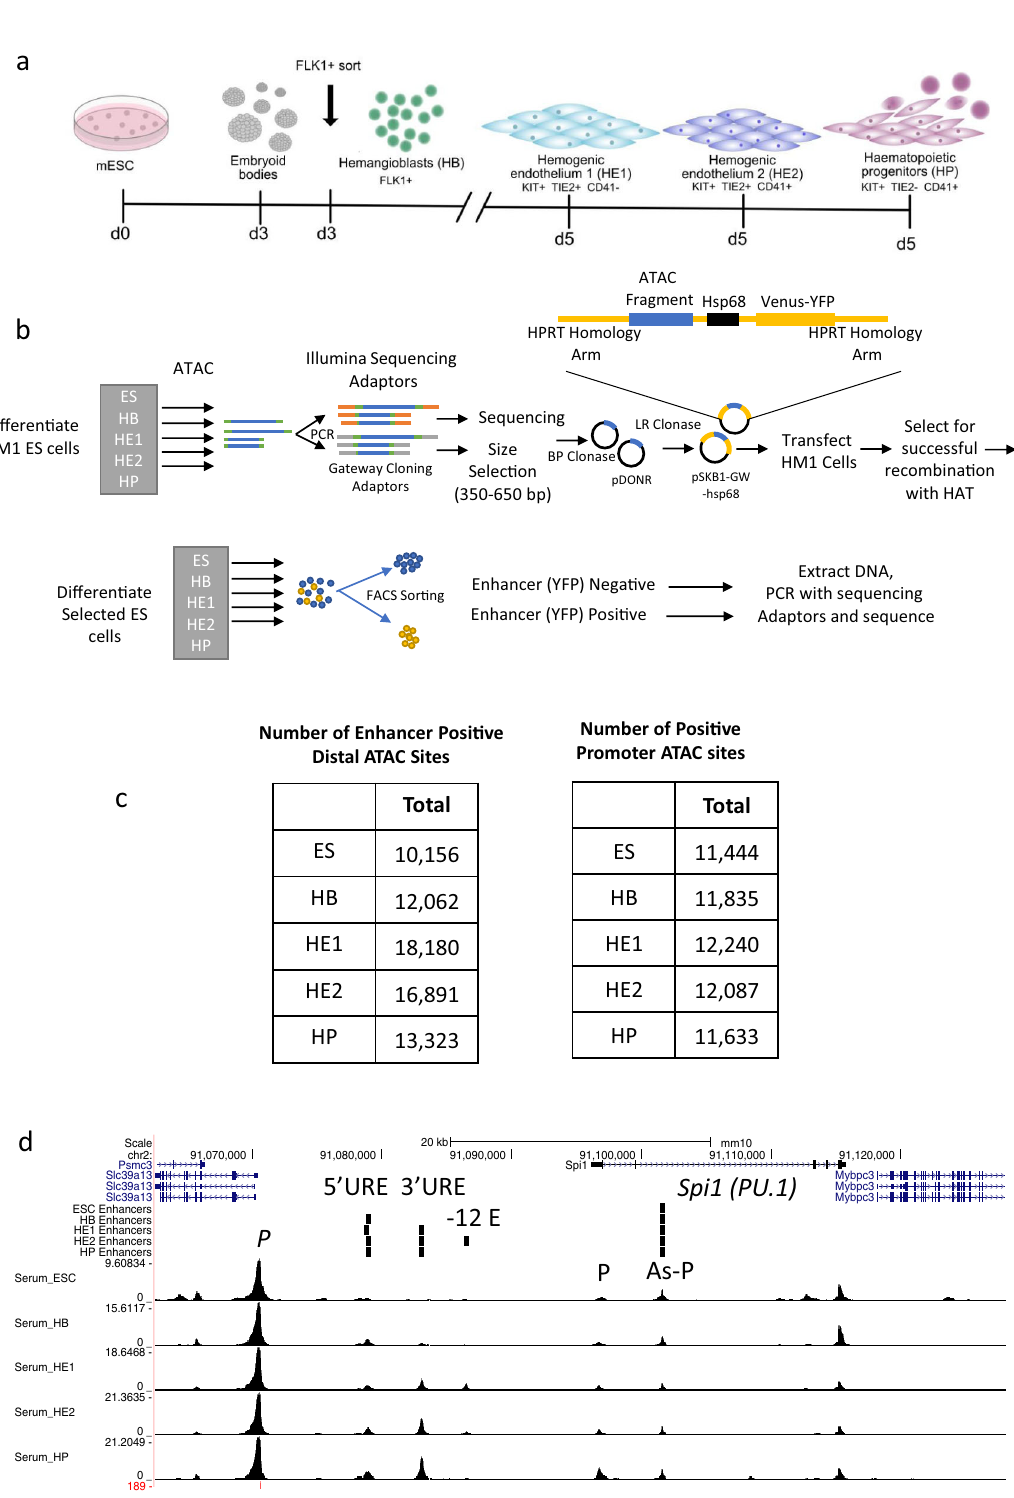
screenshot showing an example of well characterized enhancers (5 ’ URE, 3 ’ URE, − 12kb enhancer, promoter (P) and antisense promoter (As-P) from the SPI 1 (PU.1) locus 25 marked by ATAC-Seq peaks which were recovered in our screen. Distal cis regulatory elements active at the different stages scoring positive in our assay (enhancers) are indicated by vertical